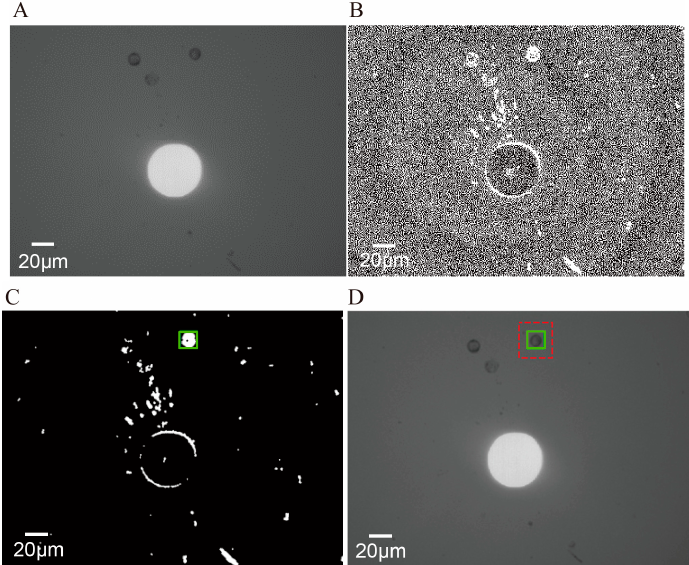
Figure 7. The background image calculated using the first 40 frames. Micromachines 2017 , 8 , 282